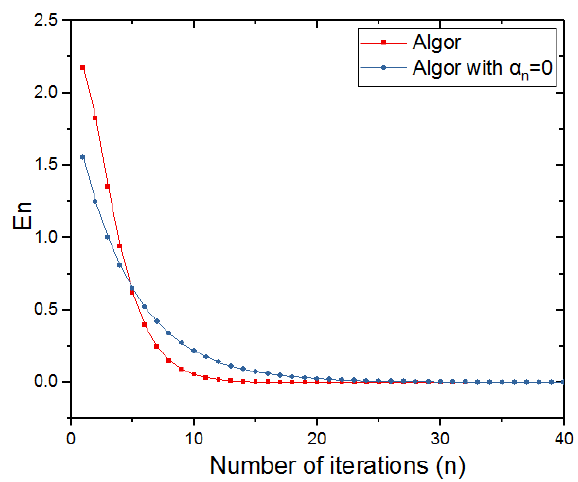
Figure 1. Error plotting of (cid:107) x n + 1 − x n (cid:107) l